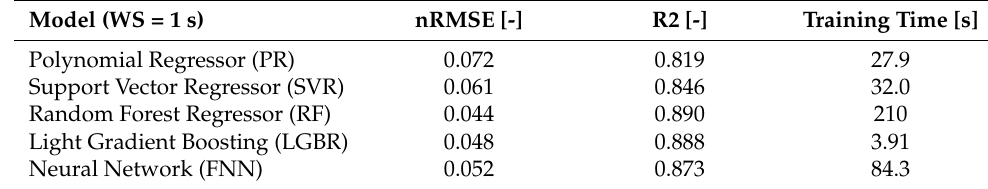
Table 5. Models’ performance using 10-sample Sliding Window (WS = 1 s).